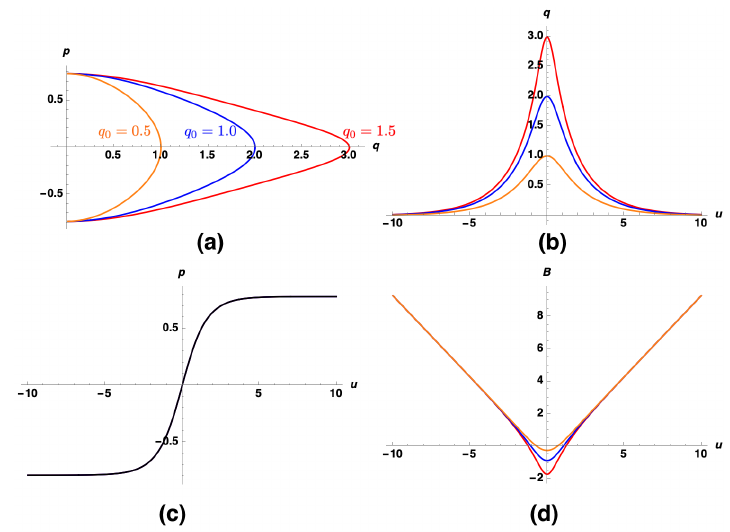
Figure 1 . (a) pq parametric plot, (b) plot of q , (c) plot of p , (d) plot of the metric function B as functions of the AdS slicing coordinate u for truncation 1. The colors denote three different values 2 for q . p = 0 for all three plots. The behavior of p is the same for all three 0 0